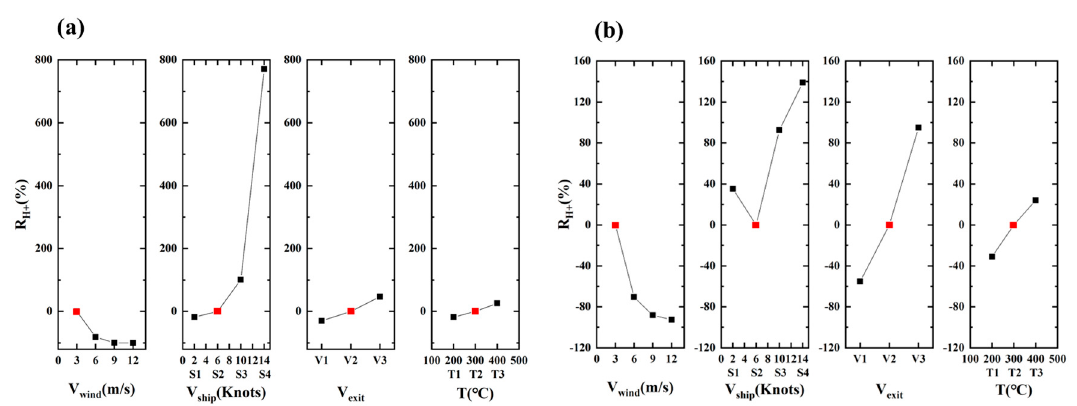
Figure 3. The rising height (H + ) of the smoke plume of the V2 group: ( a ) stationary source and ( b ) moving source.